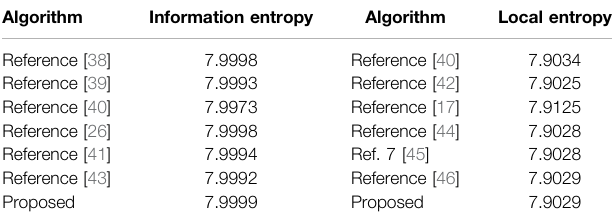
TABLE 5 | Comparison with other algorithms on entropy.